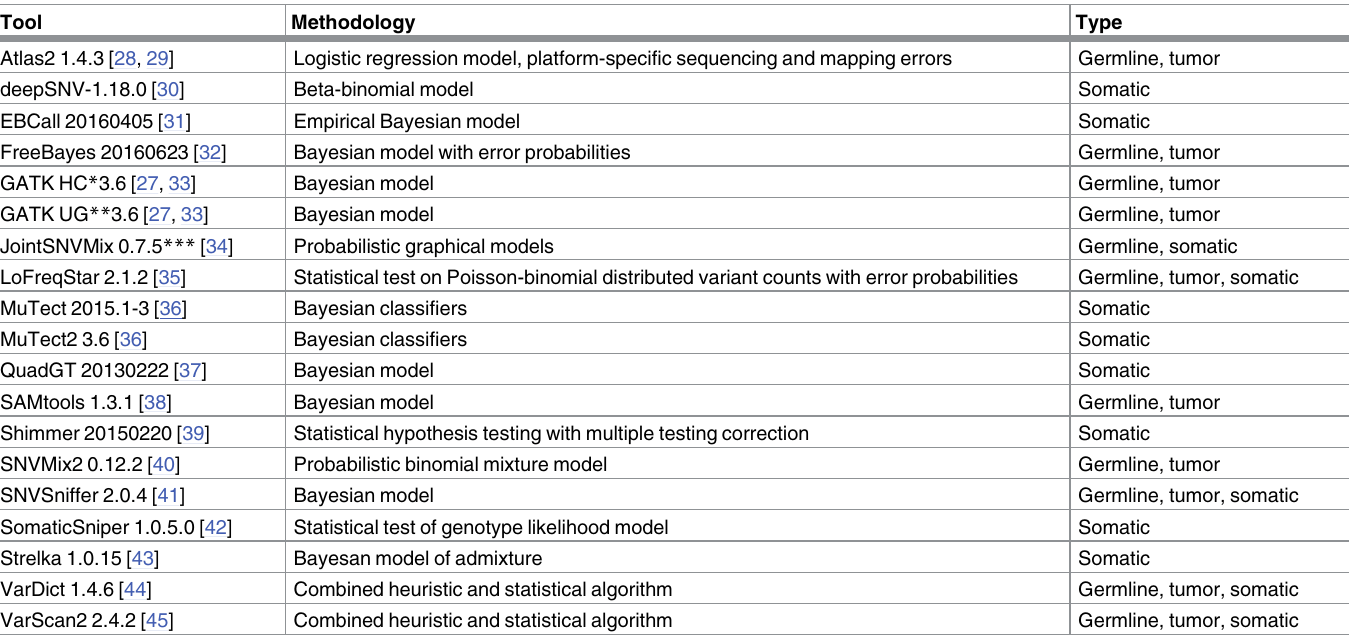
Table 1. SNV callers benchmarked in this study. The callers are labelledas the type of lineagethey call. Germline denotescallinggermlineSNVs from a single (non-tumor) sample, tumor denotescallingany SNVs (germlineand somatic) from a single tumor sample, and somatic denotescallingsomatic SNVs